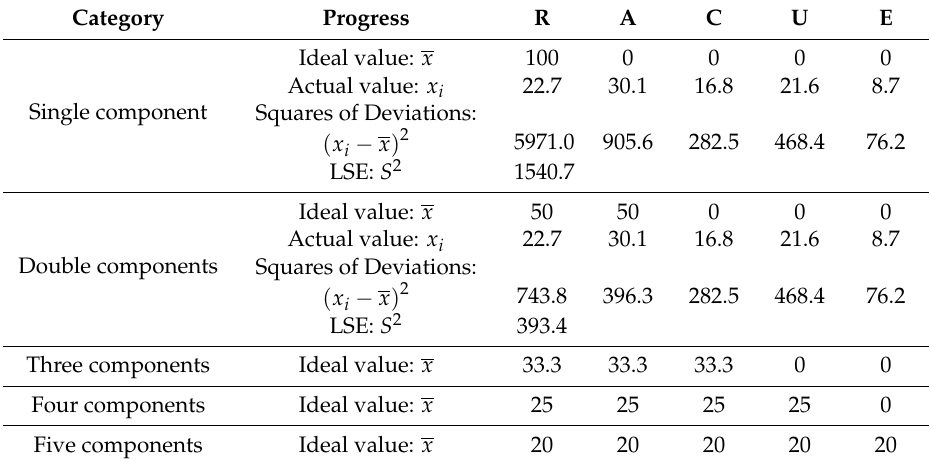
Table 4. The case calculation of Weaver Combination Index of Gouershang (rural